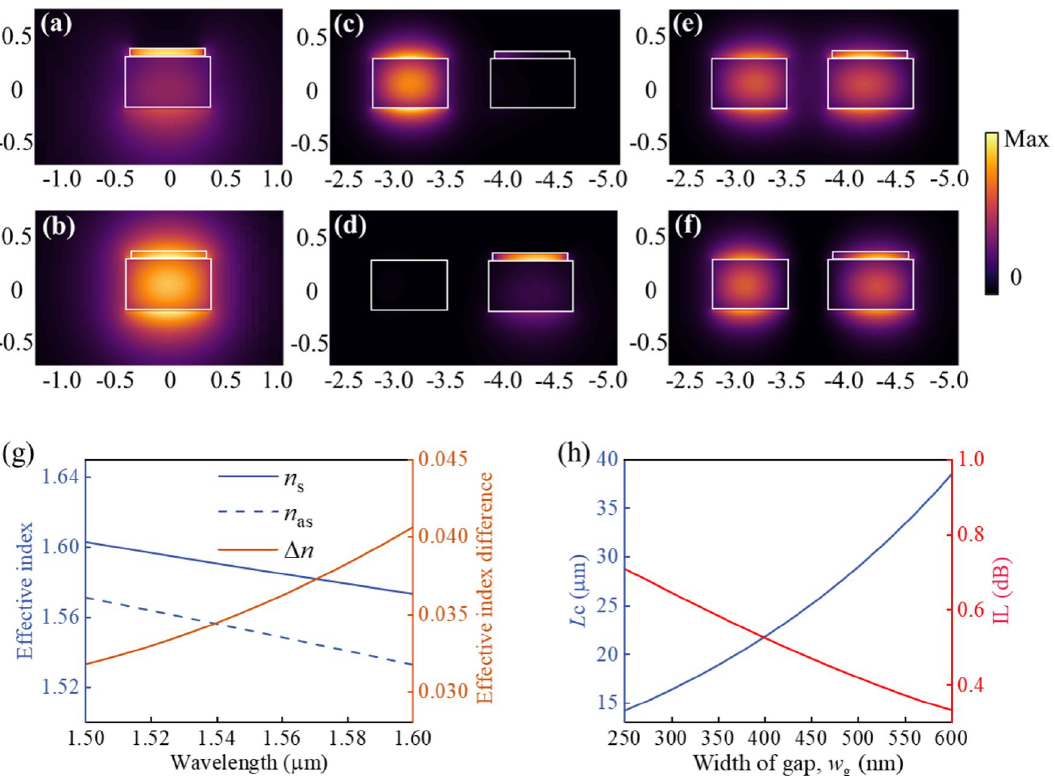
Figure 5. Mode field distribution of a SiN waveguide topped with the TCO layer in the ( a ) pump-off state and ( b ) pump-on state with pump fluence F = 0.0569 mJ cm −2 . The field intensity profile of a two-waveguide configuration with the TCO layer in the pump-off state ( c , d ), and in the pump-on state ( e , f ). ( g ) Effective index of the symmetric n s and antisymmetric n as supermodes as functions of wavelength in the pump-on state. ( h ) Coupling length L c in the pump-on state and insertion loss IL in the pump-off state as a function of gap width w g